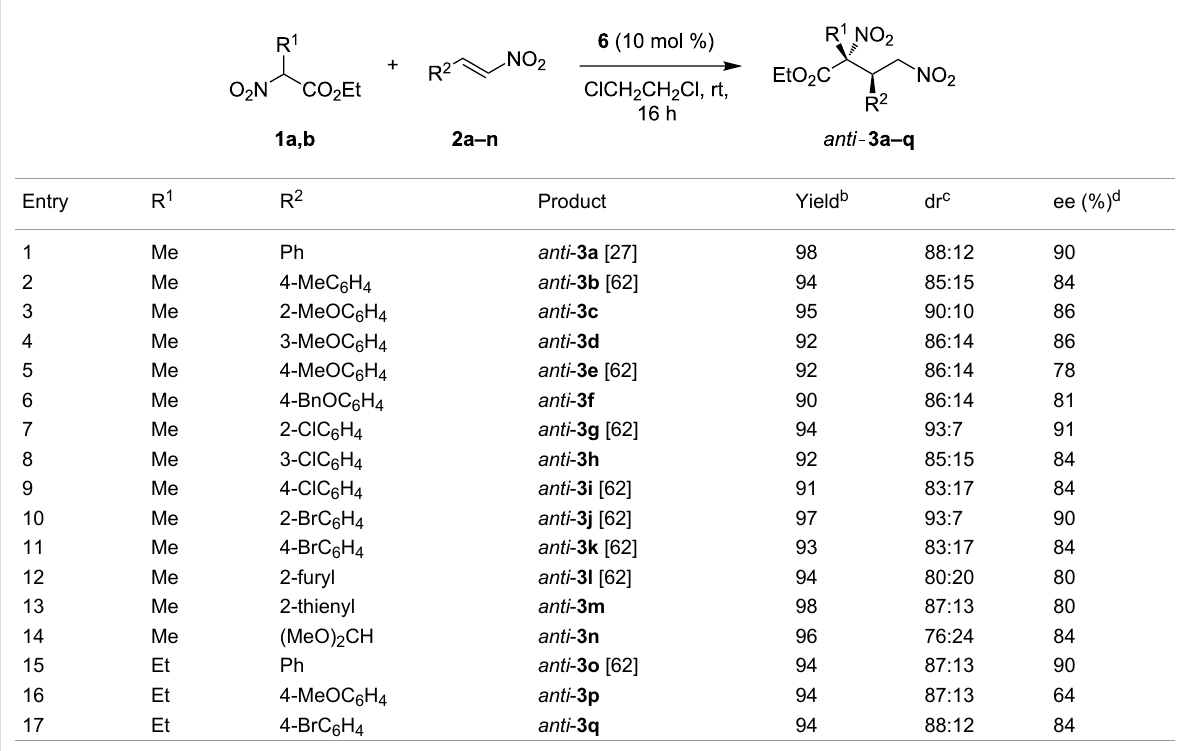
Table 2: Enantio- and diastereoselective Michael reaction between nitroesters 1 and nitroalkenes 2 catalysed by 6 . a